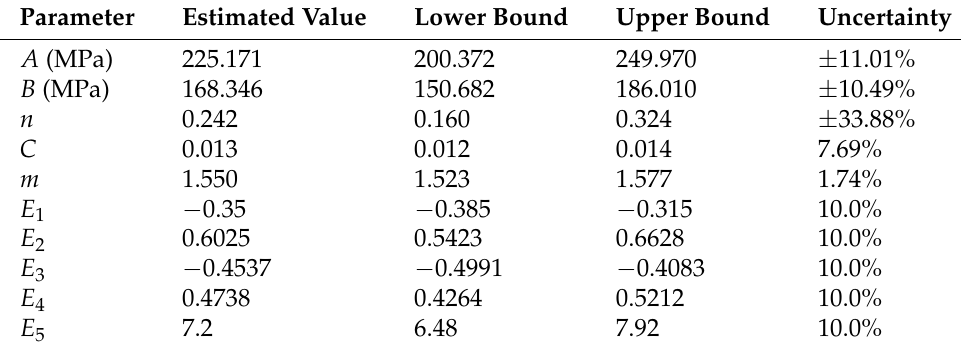
Table 1. Estimated values and bounds of AZ31B Johnson–Cook plasticity and damage